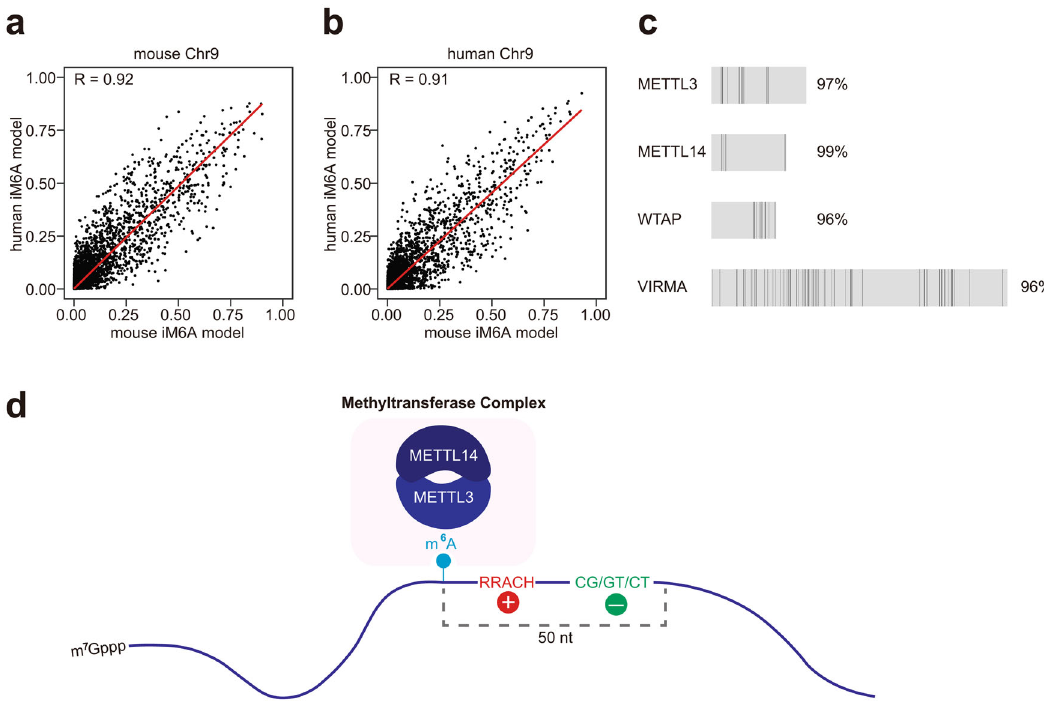
Fig. 7 Evidence for an evolutionarily conserved m 6 A regulatory code in mouse and human. a , b Scatter plot of modeled probability for the m 6 A sites ( n = 100,000) in mouse chromosome 9 ( a ) or human chromosome 9 ( b ) using mouse iM6A model versus human iM6A model. Both mouse and human iM6A models were trained independently on data of other chromosomes except chromosome 9 in mouse and human genome respectively. Each dot represented one site in mouse chromosome 9 discovered by both models, and the labeled axes provided the probability values for that site by the two models. c The protein sequences conservation of METTL3, METTL14, WTAP, and VIRMA between human and mouse. The full length of the proteins was illustrated by the gray box with individual different amino acids marked as black lines. d Cis -elements that regulate m 6 A deposition locate majorly within 50 nt downstream of m 6 A sites. The m 6 A enhancers mostly contained part of the RRACH motif; the m 6 A silencers mostly contained the CG/GT/CT